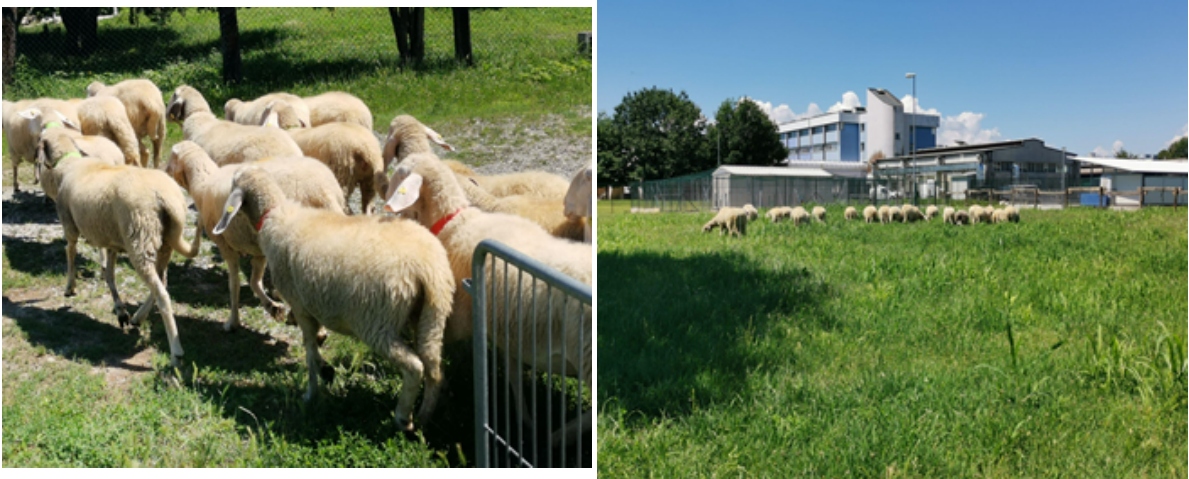
Figure 7. A flock of sheep grazing in a